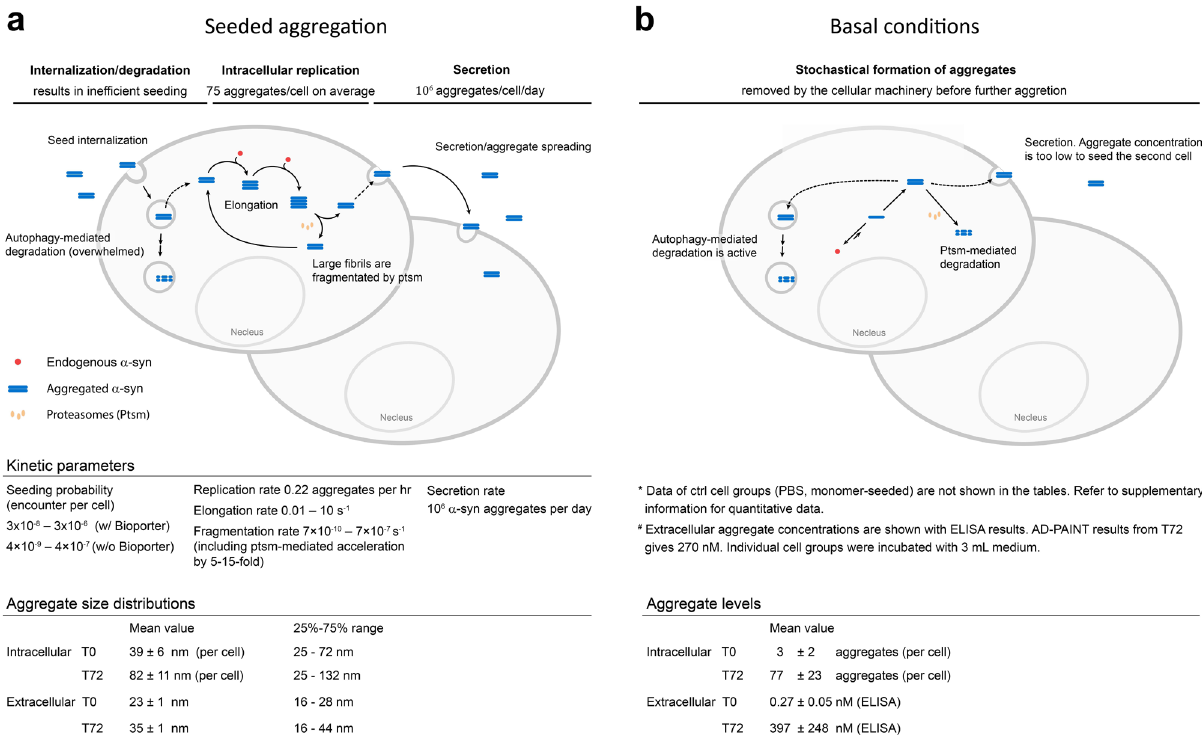
Fig. 5 Schematic summary of α -syn seeded aggregation in SH-SY5Y cells. The schematic summarizes the cellular responses after α -syn seeds are internalized measured in this study. In a , the cells can only be seeded by the fi brillar form of α -syn aggregates after sonication, not by monomeric form, in an inef fi cient way (shown as low seeding probability). The α -syn seeds that escape from autophagy-dependent degradation effectively replicate in cells by recruiting endogenous α -syn monomers. Proteasomes, which are responsible for protein degradation and quality control in cells, facilitate the replication process by accelerating fi bril fragmentation. The resulting α -syn aggregates are secreted by the cells and accumulate in the cytosol. b In contrast under basal conditions, aggregates that form in the cytosol are either degraded or secreted by the cell; hence there is no accumulation of